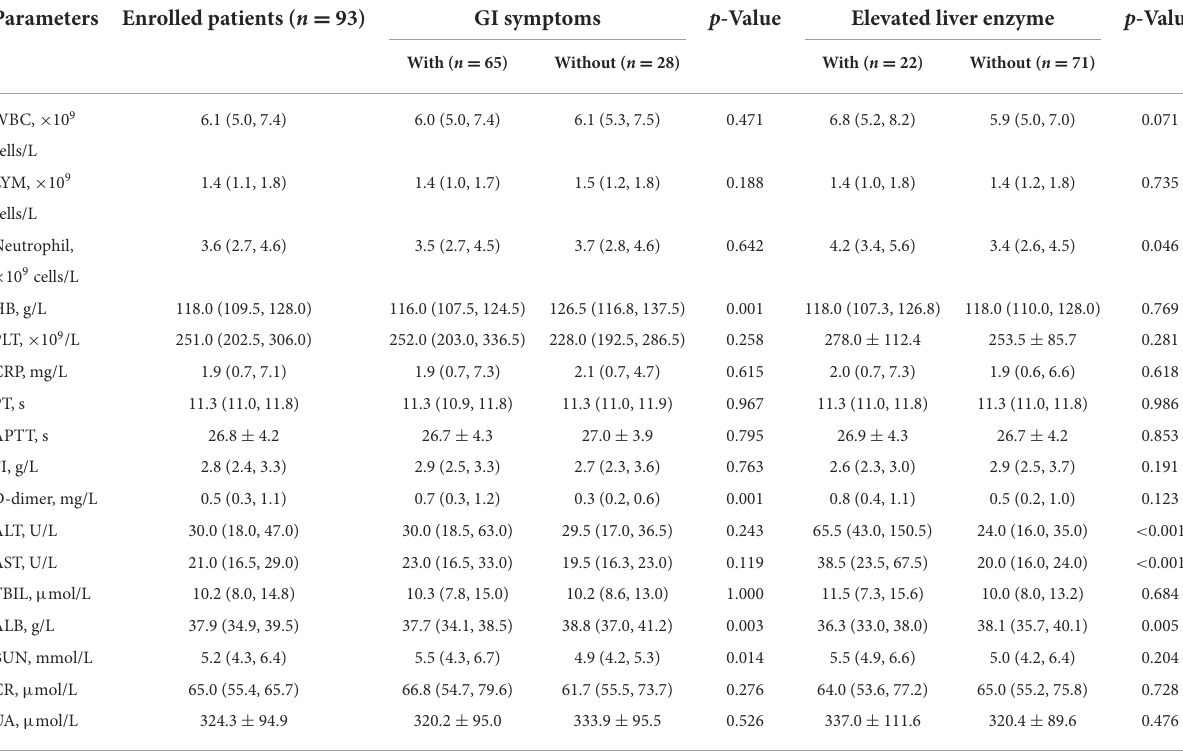
TABLE 2 Laboratory test in patients with and without GI symptoms or elevated liver enzyme. Parameters Enrolled patients ( n =